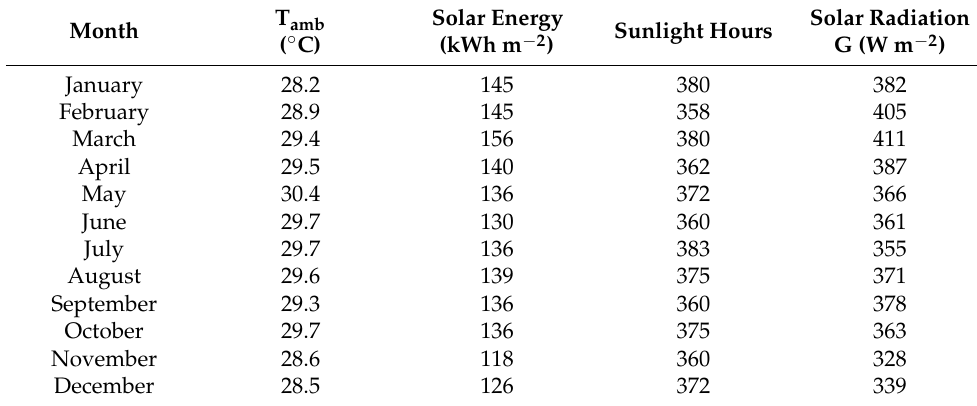
Table 4. Singapore monthly solar insolation levels and sunlight hours.